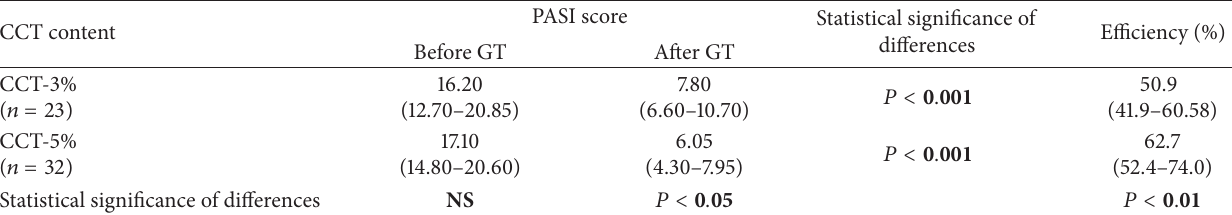
Table 4: The effectiveness of the therapy (PASI score).